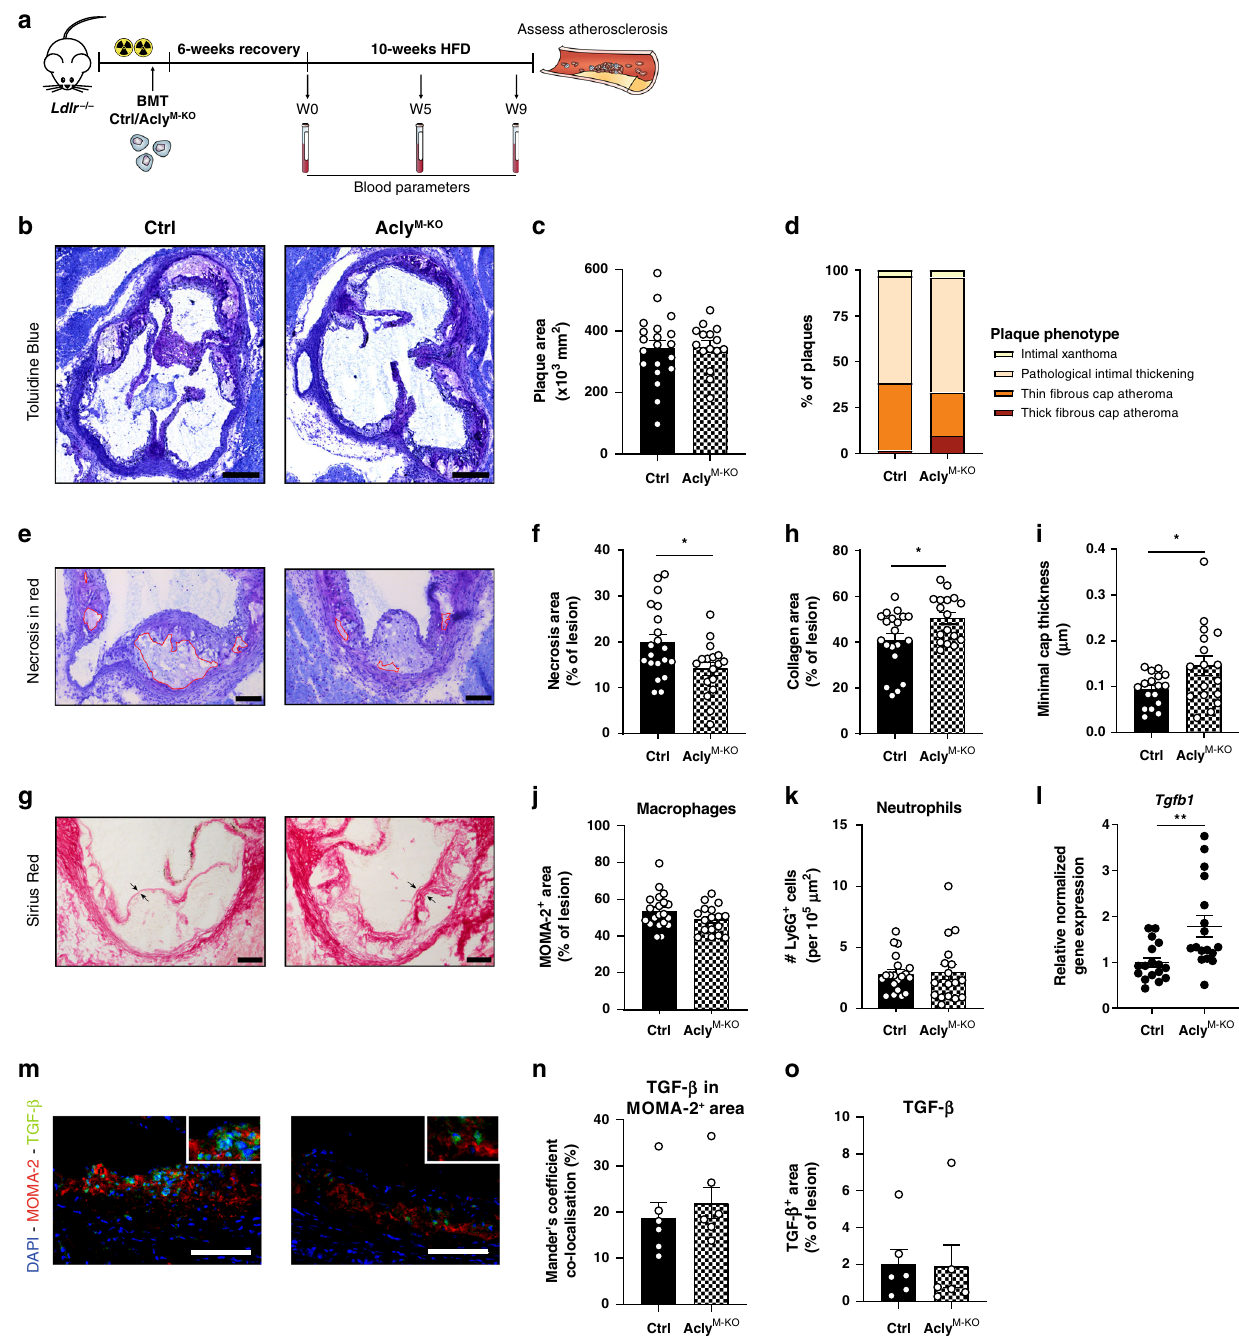
Fig. 2 Acly deletion in macrophages elicits a favorable plaque phenotype. a In order to asses atherogenesis, bone marrow cells of either control of Acly M-KO were transplanted in lethally irritated Ldlr − / − mice. Six weeks after transplantation, mice were put on a HFD for 10 weeks. b Representative toluidine blue staining of atherosclerotic plaques within the aortic roots of control and Acly M-KO mice. Scale bar represents 500 μ m. c Quanti fi cation of plaque size. d Plaque phenotypes as classi fi ed by an experimental pathologist. e Toluidine blue staining of atherosclerotic lesions with necrosis indicated in red. Scale bar represents 200 μ m. f Quanti fi cation of the necrotic area. * P = 0.0173. g Sirius red staining of plaques. Scale bar represents 200 μ m. h Quanti fi cation of the collagen deposition. * P = 0.0201. i Minimal cap thickness was measured at the thinnest region of the fi brotic cap surrounding the necrotic core as indicated by the arrows in g . * P = 0.0292. j Quanti fi cation of MOMA-2 + area for macrophages. k Quanti fi cation of Ly6G + area for neutrophils. l Normalized expression of Tgfb1 in aortic arches of control and Acly M-KO mice. ** P = 0.0038 m Representative immunohistochemical analysis of macrophages (MOMA-2) and TGF- β in mouse plaques from control or Acly M-KO mice ( n = 6/6 ctrl/KO from one experiment). Scale bar represents 100 µ m. n Quanti fi cation of colocalization, percentage of TGF- β + area in MOMA-2 + area. o Quanti fi cation of TGF- β + area in the lesion. Values represent mean ± SEM ( n = 20/17 (ctrl/KO in b – l ), n = 6/6 (ctrl/KO in n , o ). * P < 0.05; ** P < 0.01 by two-tailed Student ’ s t test ( f , h , i , l ). Source data are provided as a Source Data fi le ( c , d , f , h – l , m , o